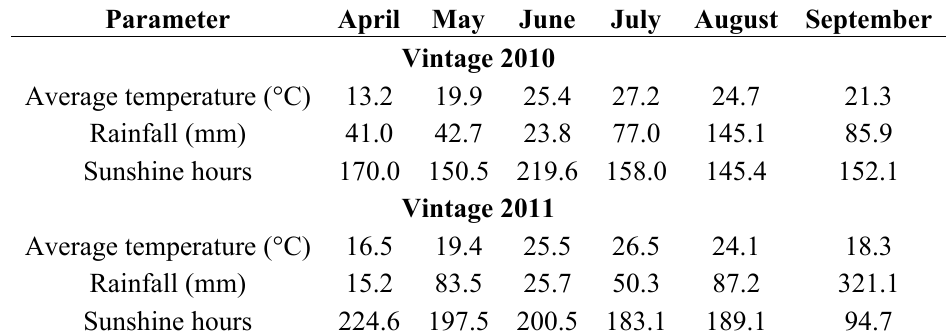
Table 5. Mesoclimate of vineyard during the growing season of the 2010 and 2011 vintage. Parameter April